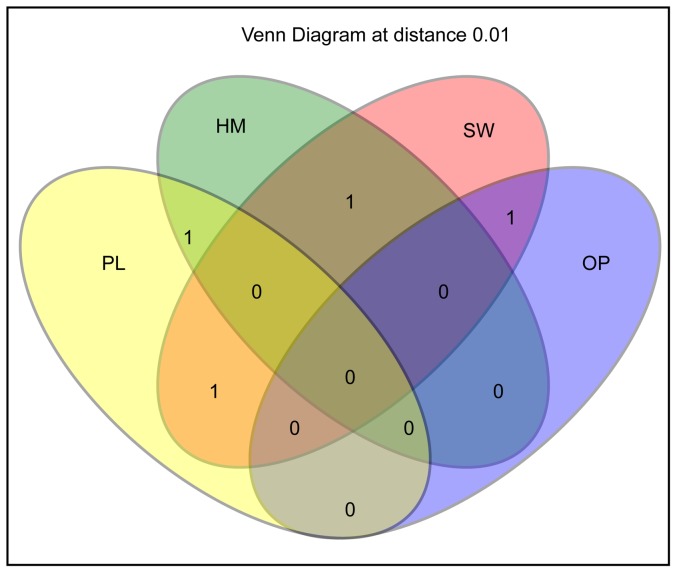
Venn diagram representing the distribution of shared OTUs among sponge hosts H. perlevis (HM), O. papilla (OP), P. penicillus (PL) and seawater (SW).The numbers in the diagram represents unique and shared OTUs.